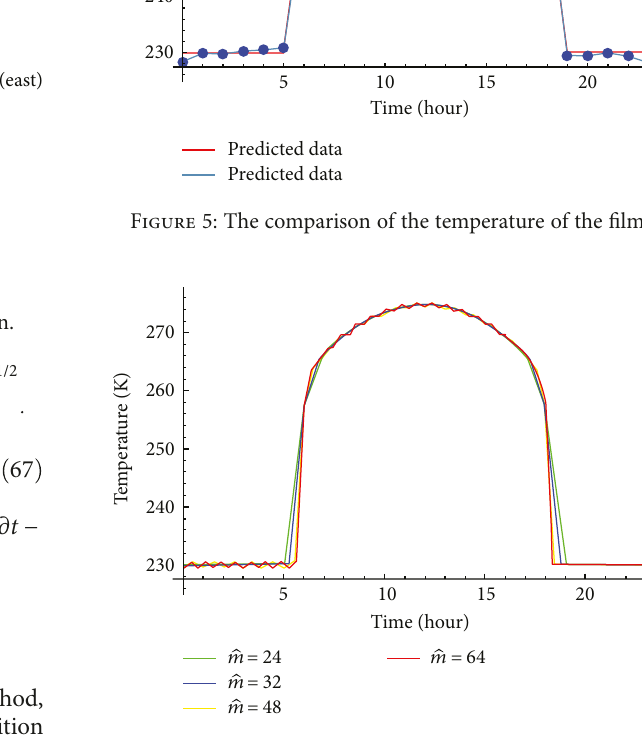
Figure 6: The comparison of the temperature of the fi lm for di ff erent ̂ m